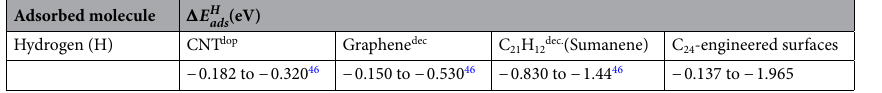
H Table 3. Referenced adsorption energies ( (cid:31) E ads ) of Fullerene engineered surfaces towards adsorbed hydrogen together with adsorption energies of other carbon-based structures towards studied molecule (H) with corresponding references in square brackets.